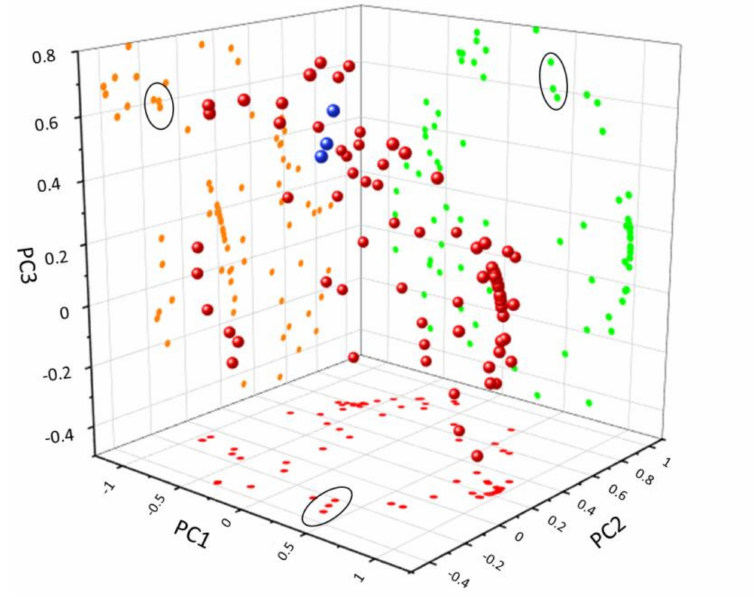
Figure 11. Loading plots based on PC1, PC2, and PC3 components; blue spheres and circled points refer to chemical shifts of